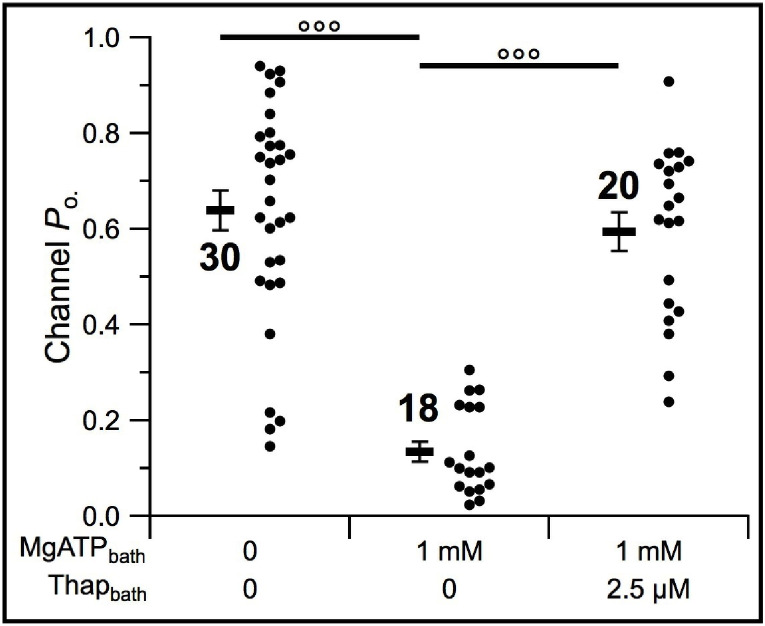
Thapsigargin abrogated SERCA activity despite the presence of bath MgATP.[Ca2+]ER in intact isolated DT40-r3 nuclei equilibrated with [Ca2+]bath. InsP3R channel Po of thapsigargin-treated nuclei were high, indistinguishable from Po of nuclei exposed to no bath MgATP or thapsigargin. Channel Po of individual current traces (circles) and their averages and s.e.m. (horizontal bars) are plotted for on-nuc patch-clamp experiments performed with bath solution containing 70 nM [Ca2+]bath. There is significant difference between Po of channels in solutions with and without MgATP (both with no thapsigargin); and between Po of channels in in solutions with and without thapsigargin (both with 1 mM MgATP). The controls (0 MgATP and 0 thapsigargin; 1 mM MgATP and 0 thapsigargin) and experiments (with thapsigargin and MgATP) were performed using cells harvested within at most one day apart to ensure that the qualities of the cells were similar.